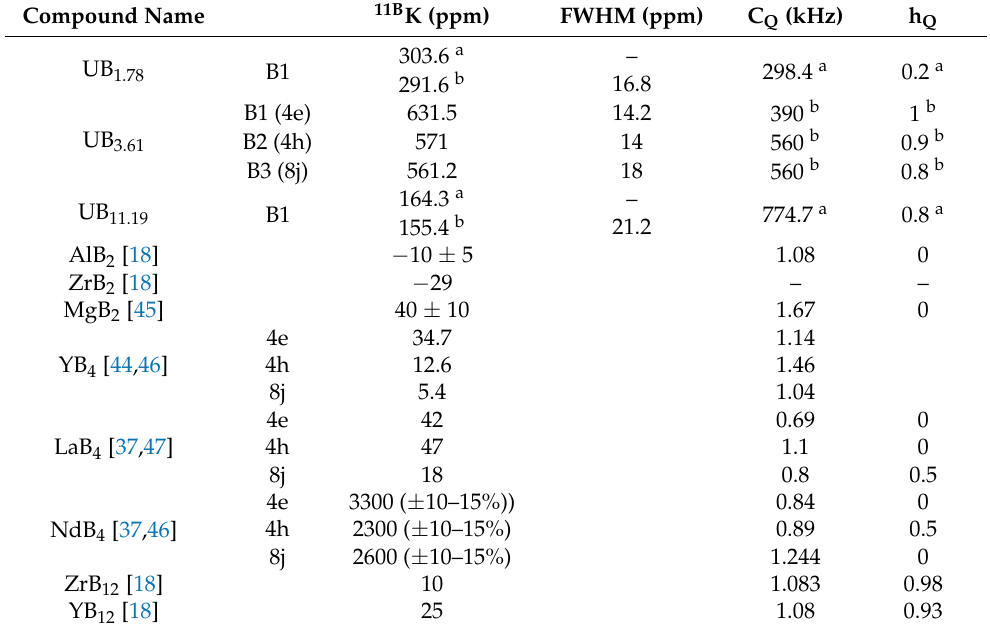
Table 5. 11 B NMR parameters Knight shifts ( 11B K), quadrupolar coupling constant (C Q ), and asym- metry parameter ( η Q ) of the uranium borides